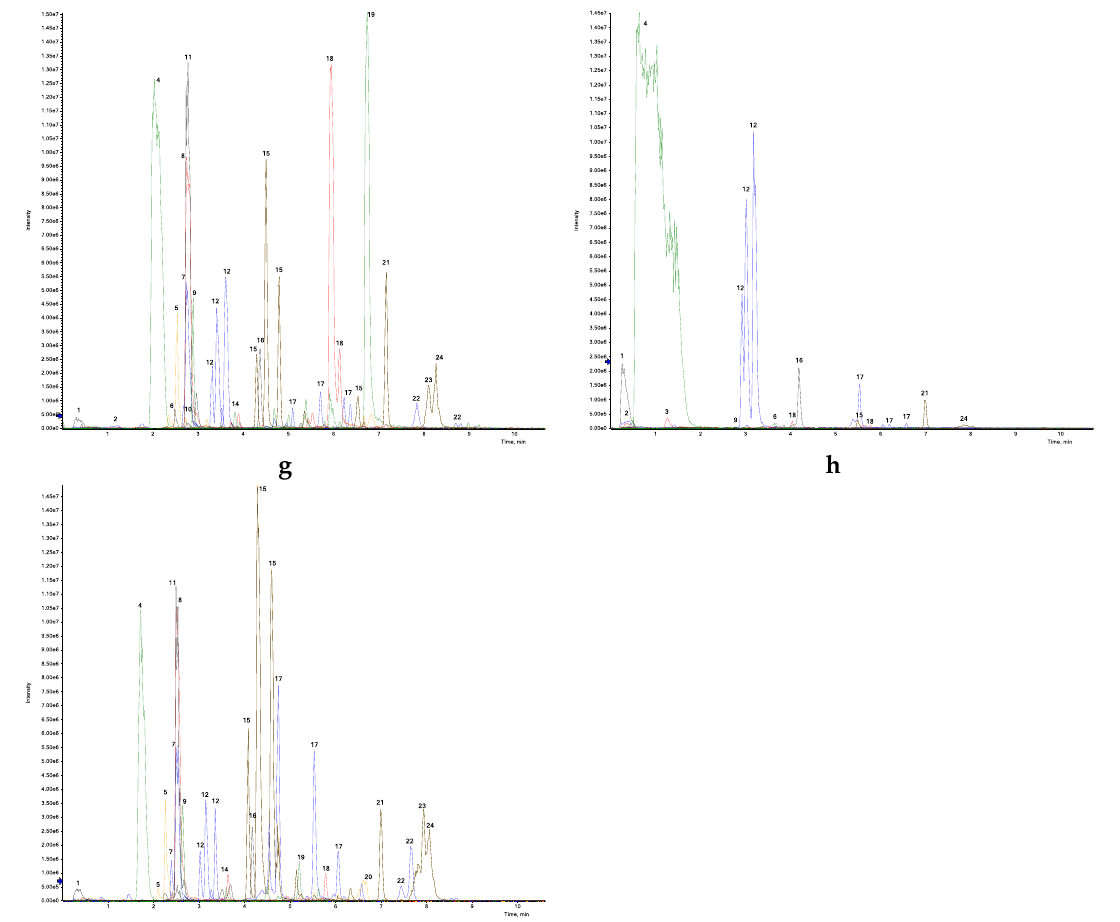
Figure 1. Chromatogram representing relative abundance of polyphenols and terpenoids in different extracts of rosemary leaves (T 1 – T 9 ) analyzed through ultra-high-performance liquid chromatography with electrospray ionization and quadrupole-time of flight mass spectrometry (UHPLC-ESI-QTOF-MS) (intensity versus elution time); ( a ) Fresh tissue homogenization (T 1 ); ( b ) Fresh homogenized tissue extract fermentation (T 3 ); ( c ) Fresh leaf decoction (T 2 ); ( d ) Fresh leaf decoction fermentation (T 4 ); ( e ) Dry leaf decoction (T 5 ); ( f ) Dry leaf decoction fermentation (T 6 ); ( g ) Soxhlet extraction (T 7 ); ( h ) Sonication with water (T 8 ); ( i ) Sonication with methanol (T 9 ). Peak numbers refer to: 1 — quinic acid;